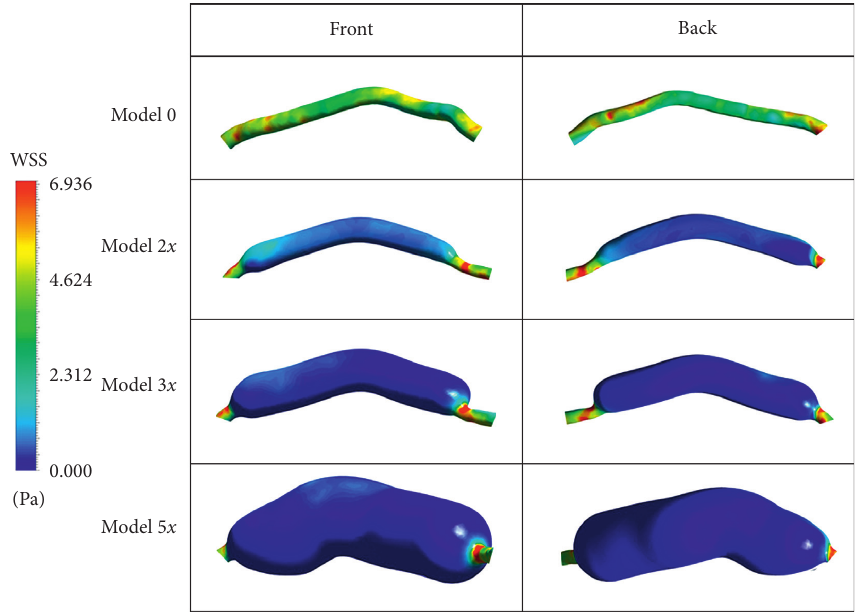
Figure 6: Wall shear stress (WSS) distribution in the coronary artery aneurysm at its peak ( t � 0.2 s) for the four